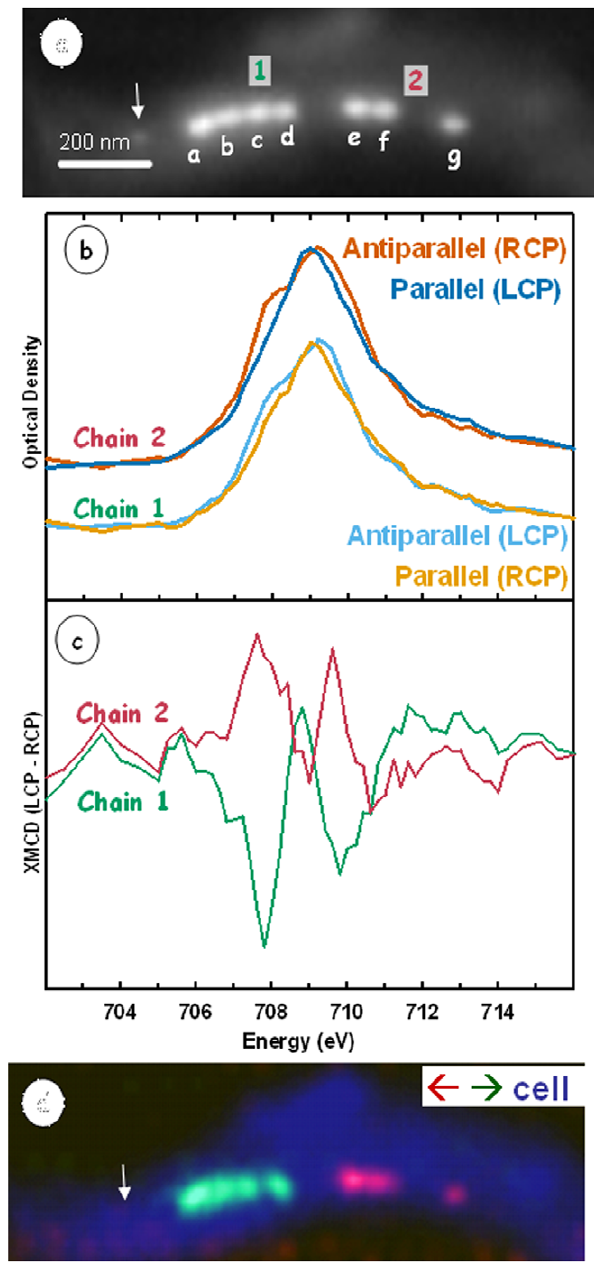
Figure 2. X-ray magnetic circular dichroism (XMCD) of an MV-1 cell with a chain of magnetosomes containing two gaps. (a) STXM image (OD). The two sub-chains are labelled chain 1 and chain 2. Each magnetosome has been labelled a-g. (b) Fe 2p 3/2 spectra from the left chain (upper) and the right chain (lower) recorded with the two circular polarizations. (c) XMCD signals derived by subtracting the two circular polarization spectra. (d) Color coded composite of the cell (OD image at 704 eV) (blue), magnetosomes with a leftward polarization (green), and a rightward polarization (red). The arrows in Figs (a) and (d) indicate a ‘pre-magnetosome’ – see text.